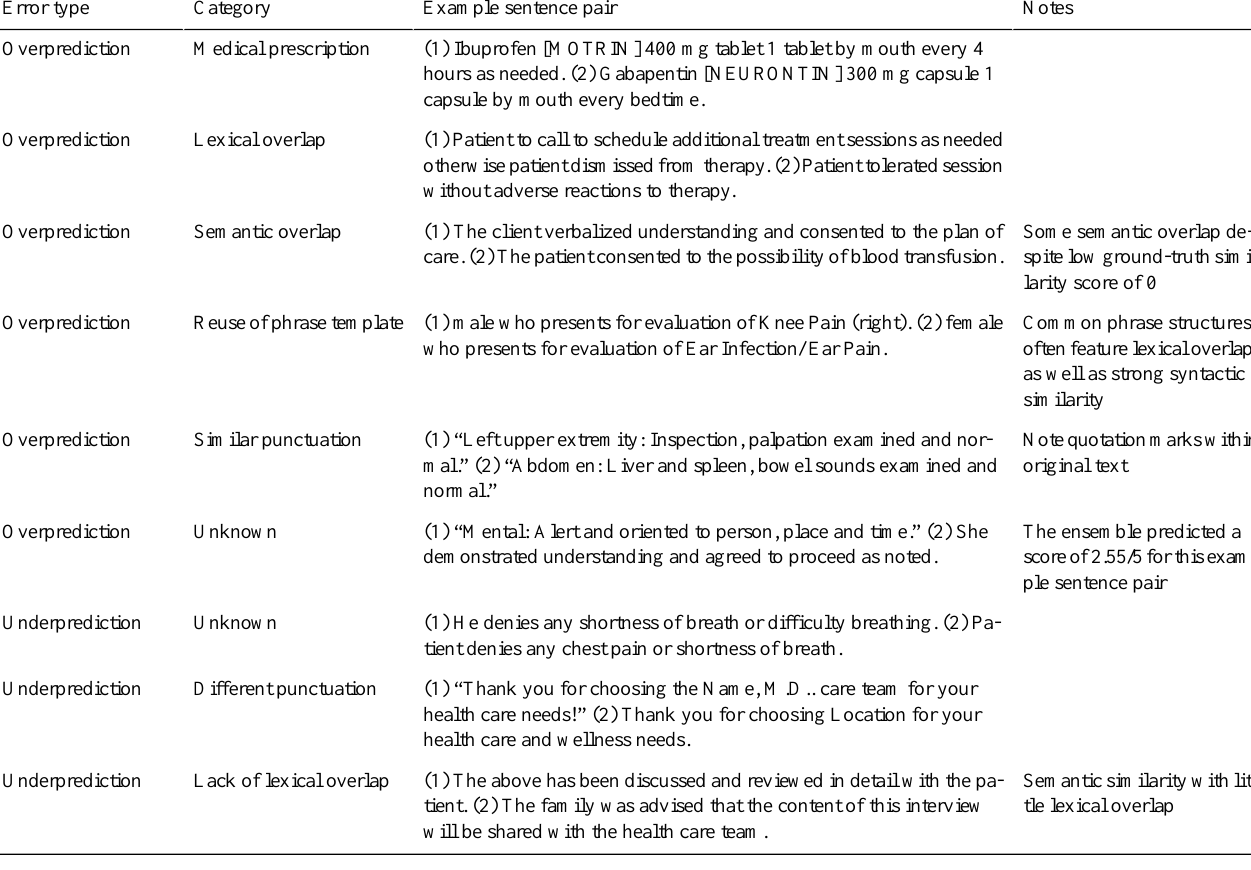
Table 3. Example sentence pairs and error type (ie, whether the transformer ensemble overpredicted or underpredicted semantic similarity with respect to the ground truth) for each error category selected for the qualitative